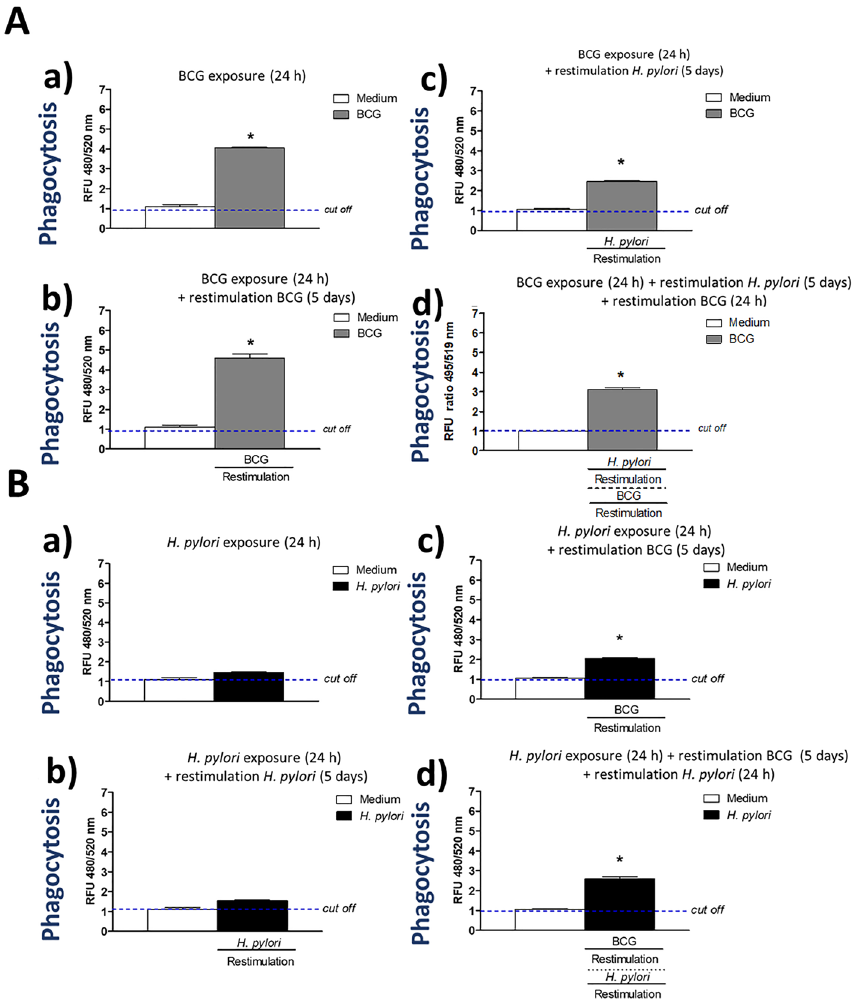
Figure 2. The role of priming/restimulation of THP-1 macrophages with M. bovis BCG in the enhancement and the maintenance of increased phagocytic activity of these cells in Vybrant phagocytosis assay using green- labeled E. coli . Phagocytic activity of THP-1 macrophages primed with M. bovis BCG ( A ) towards E. coli : cells primed for 24 h with M. bovis BCG (a); cells primed for 24 h with M. bovis BCG and restimulated for 5 days with M. bovis BCG (b); cells primed for 24 h with M. bovis BCG and restimulated for 5 days with H. pylori (c); cells primed for 24 h with M. bovis BCG then restimulated for 5 days with H. pylori and for an additional 24 h with M. bovis BCG (d). Phagocytic activity of THP-1 derived macrophages primed with H. pylori towards E. coli ( B ): cells primed for 24 h with H. pylori (a); cells primed for 24 h with H. pylori and restimulated for 5 days with H. pylori (b); cells primed for 24 h with H. pylori and restimulated for 5 days with M. bovis BCG (c); cells primed for 24 h with H. pylori , restimulated for 5 days with M. bovis BCG and an additional 24 h with H. pylori (d). Results are presented as median fluorescence units (RFU) ratio ± range of three independent experiments. The difference statistically significant when p < 0.05 in Mann–Whitney U test. *Cells stimulated versus unstimulated (according to the time of stimulation). BCG or H. pylori MOI